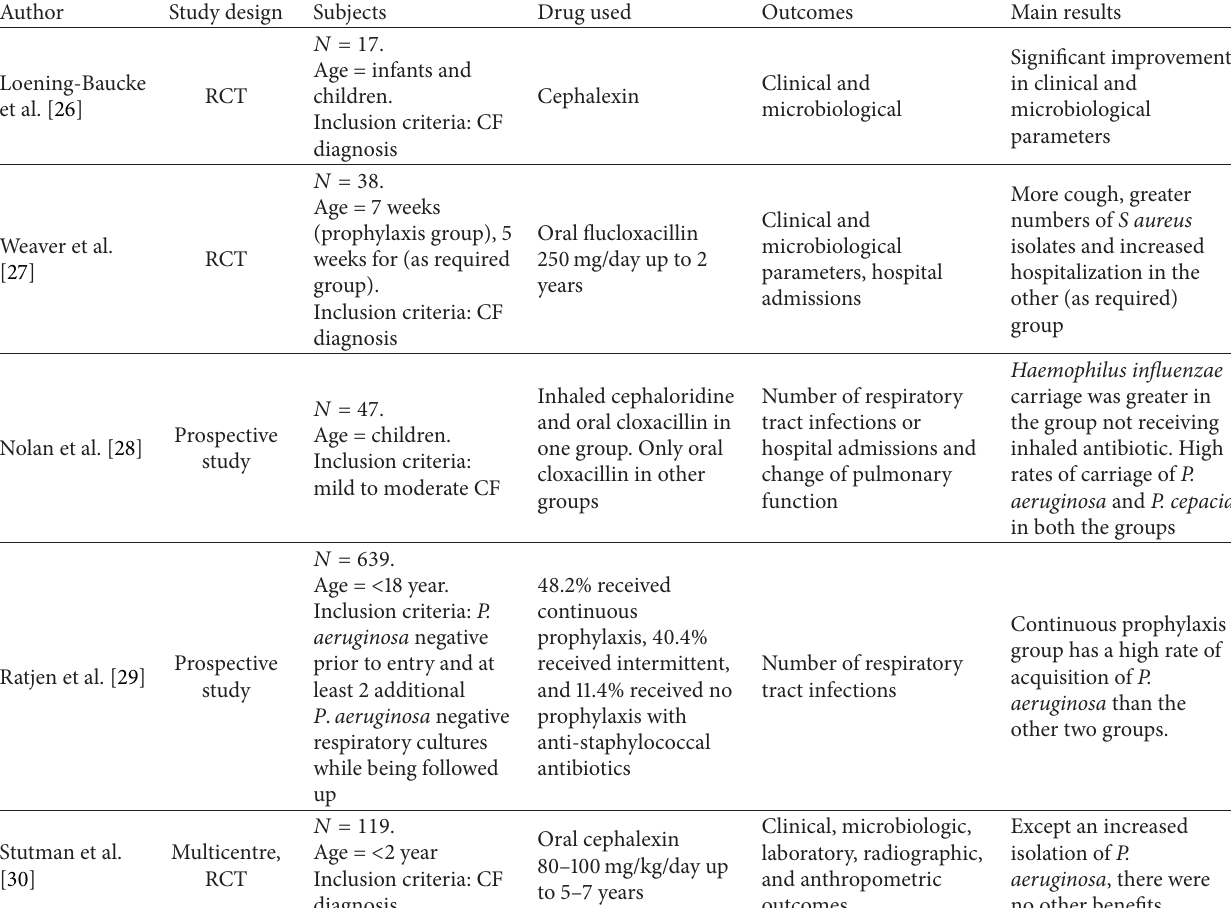
Table 5: Summary of studies on early chronic suppressive therapy of